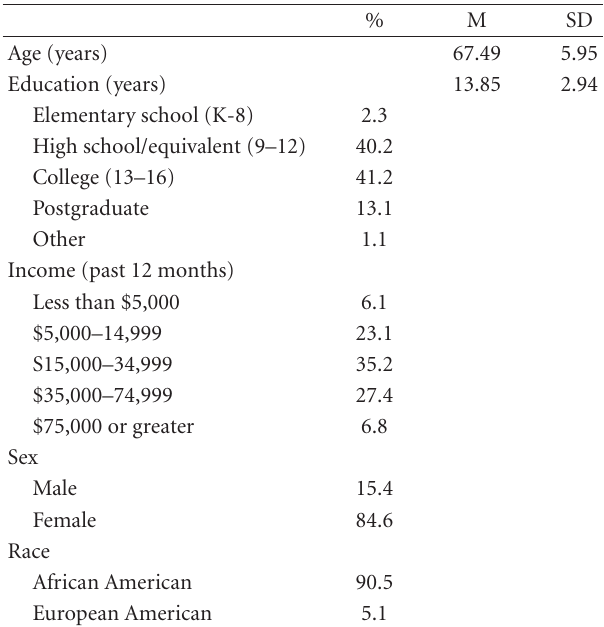
Table 1: Demographic characteristics of